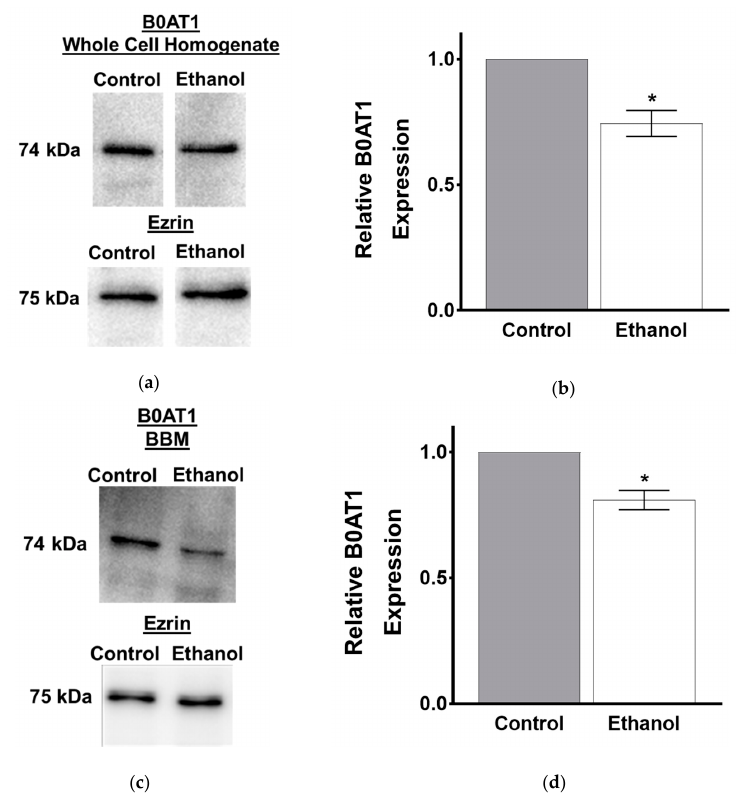
Figure 8. Ethanol decreased the protein expression of B0AT1 in IEC-18 cells. ( a ) Western blot analysis of B0AT1 protein expression in whole cell homogenates from control and ethanol-treated cells. The blots show a representative sample used for densitometric quantification. ( b ) Densitometric quantification of B0AT1 protein expression was significantly decreased in whole cell homogenates after one-hour exposure of ethanol (* p < 0.05, n = 6). ( c ) Western blot analysis of BBM B0AT1 protein expression from control and ethanol-treated cells. The blots show a representative sample used for densitometric quantification. ( d ) Densitometric analysis of B0AT1 protein expression was significantly decreased in the BBM fraction after one-hour exposure of ethanol (* p < 0.05, n = 4). All lanes were run on the same membrane. The error bars represent the SEM. To assure equivalence of loading, the blots were normalized with anti-ezrin antibodies.